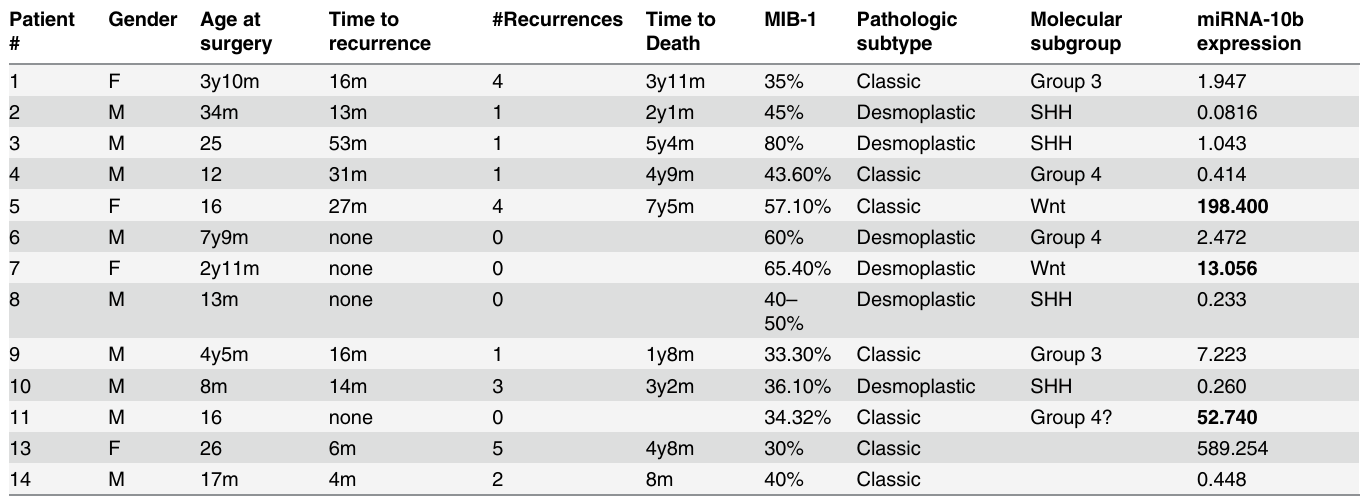
Table 1. miRNA-10b expression correlates with survival and recurrence in human medulloblastoma patient samples. Human biopsy samples were subjected to RNA extraction followed by generation of cDNA, and subjected to RT-PCR for analysis of miRNA-10b expression. The fold expression of miRNA-10b was compared to the normal cerebellar control. miRNA-10b expression was correlated with the patients ’ clinical and pathological history. Patient Gender Age at #